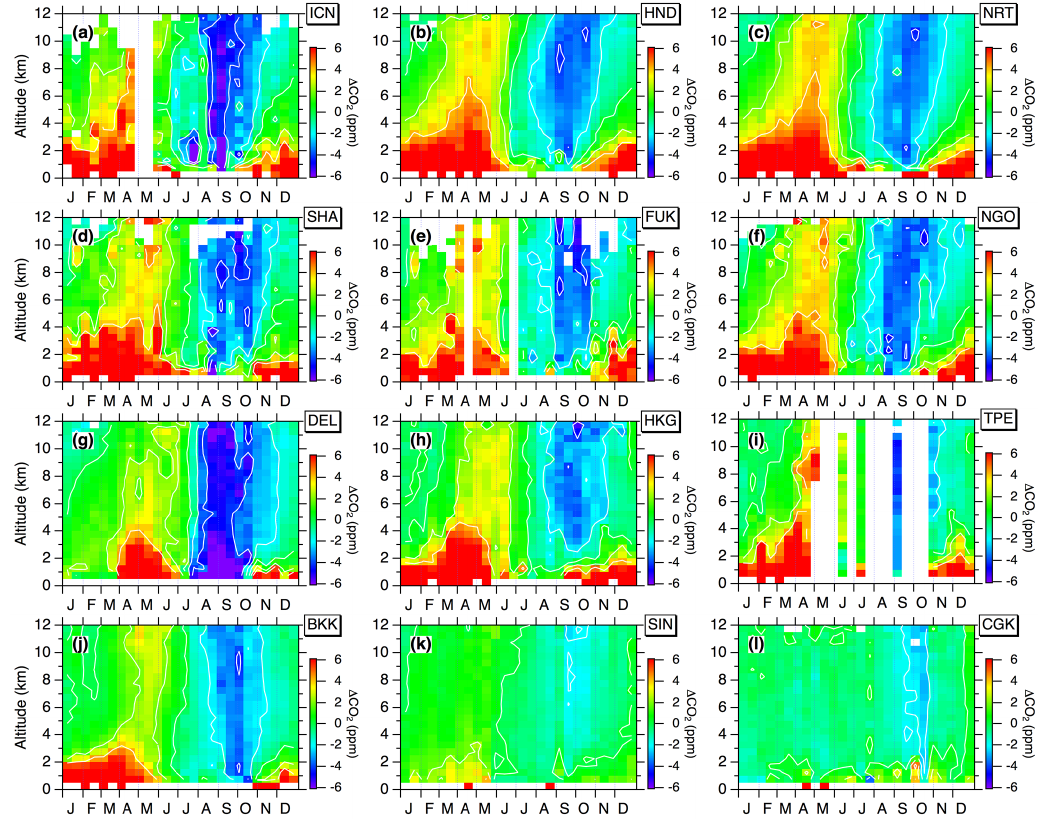
Figure 4. Seasonal variations in vertical profiles of (cid:49) CO 2 over (a) ICN, (b) HND, (c) NRT, (d) SHA, (e) FUK, (f) NGO, (g) DEL, (h) HKG, (i) TPE, (j) BKK, (k) SIN, and (l) CGK. The airport codes are listed in Table 1. The CO 2 data over some airports are merged, as described in Fig. 2. Vertical and horizontal bins are 500m and 14-day intervals, respectively. White lines indicate isolines of (cid:49) CO 2